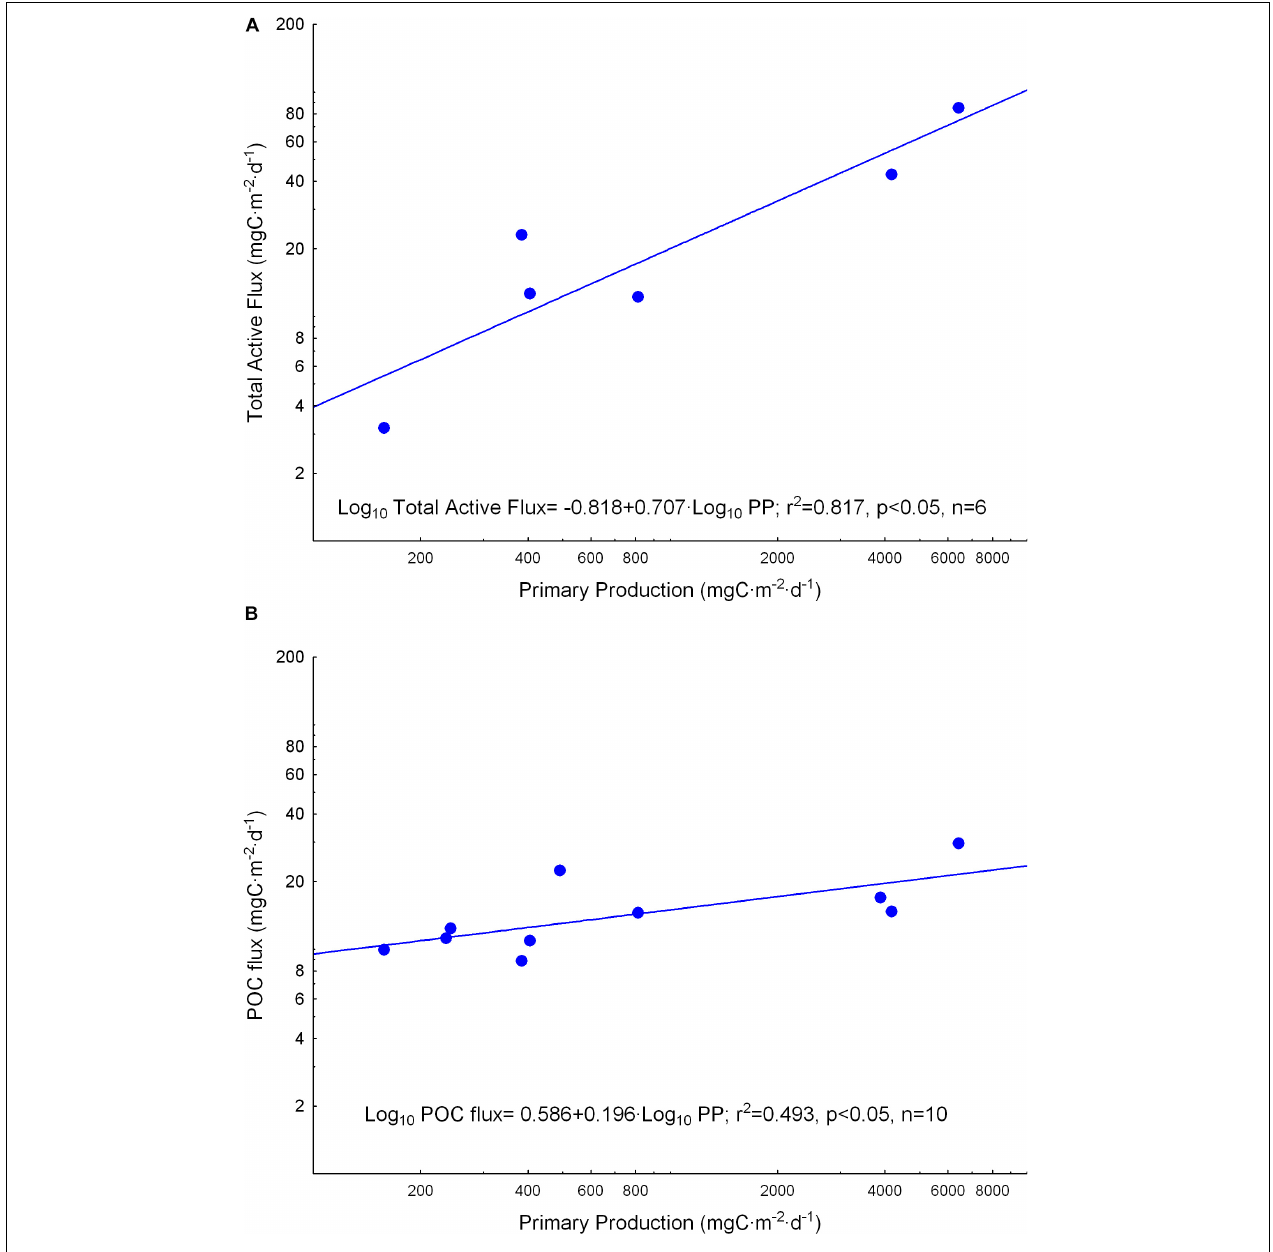
FIGURE 11 | Relationships between primary production obtained from remote sensing (VGPM model) and (A) total active flux by zooplankton and micronekton, and (B) particle organic carbon (POC) flux measured using drifting sediment traps at 150 m